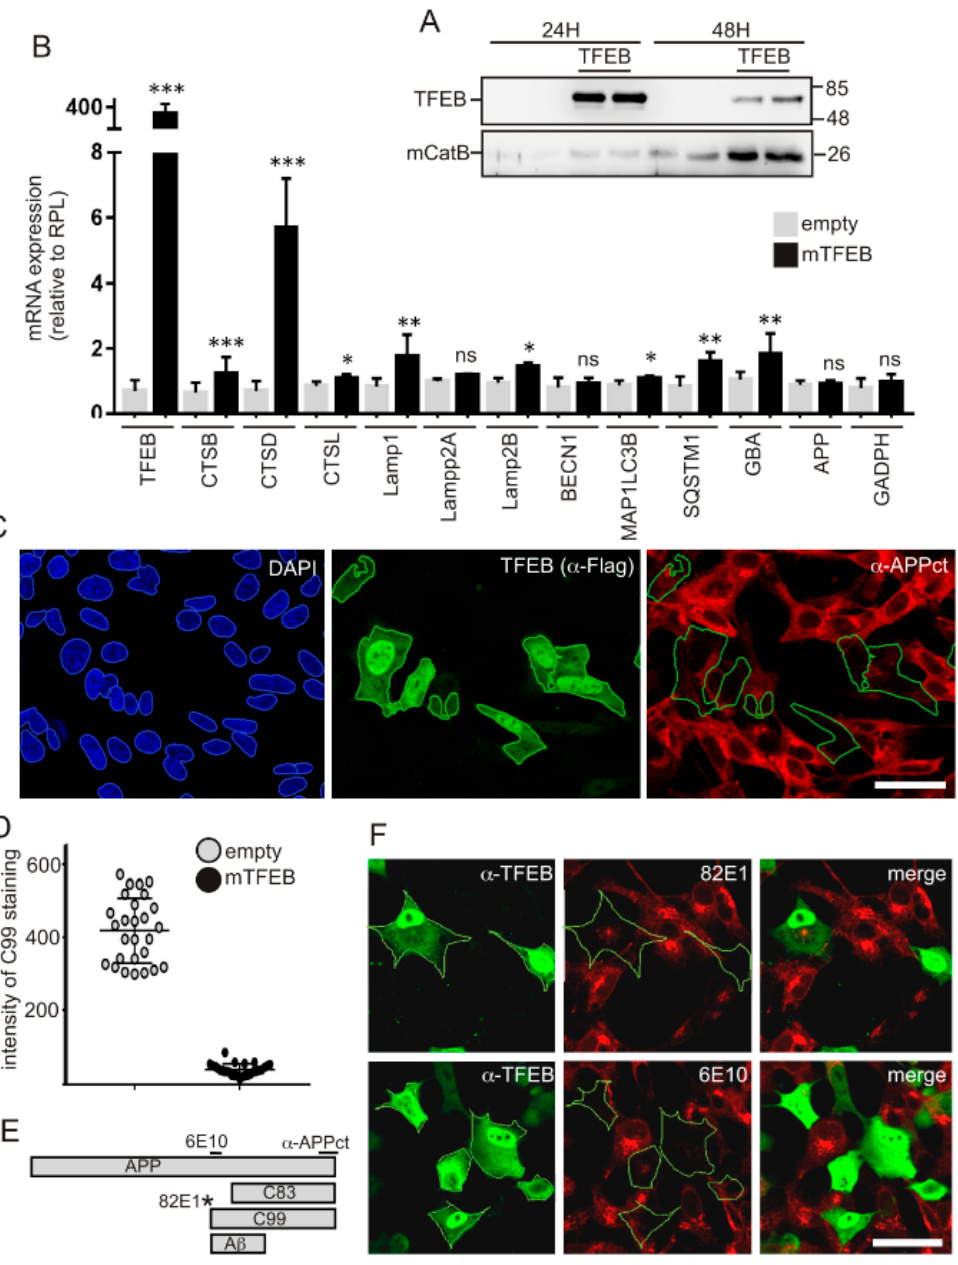
Figure 1. Transcription factor EB (TFEB) overexpression in SH-SY5Y-APPswe cells leads to induction of lysosomal-autophagic gene products and to reduced C99 levels. Statistical differences were * p < 0.05, ** p < 0.01, *** p < 0.001, ns = non significant ( p > 0.05), versus control cells (empty) according to the Mann–Whitney test. ( A ) Immunoblot analysis revealed the levels of overexpressed TFEB and endogenous cathepsin B at 24 h or 48 h post-transfection. TFEB is detected using α -FLAG. ( B ) qPCR analysis of TFEB-mediated gene transcription showed the induction of numerous lysosomal-autophagic genes. Gene expressions were normalized to the expression of the housekeeping gene RPL19 and represented in each case relatively to mock-transfected cells ( C ) SH-APPswe cells were transfected with TFEB cDNA and immunostained at 48 h post-transfection with α -FLAG (for TFEB detection) and α -APPct. NucleiwerestainedwithDAPI.( D )Quantificationof α -APPctstaininginTFEB-positiveversus TFEB-negative cells. ( E ) Illustration of epitope recognition by the di ff erent antibodies. ( F ) SH-APPswe cells were immunostained with α -TFEB (green labeling) and either 82E1 or 6E10 (red labelings). Bar scale: 10 µ